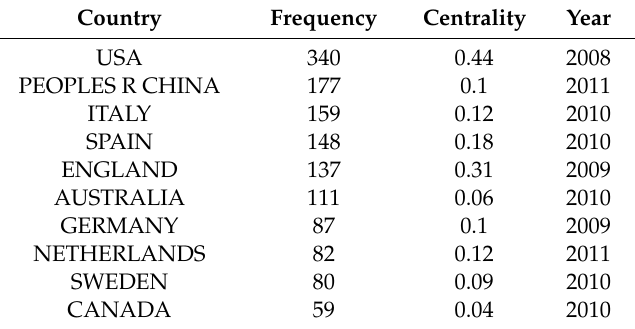
Table 7. Top 10 countries based on occurred